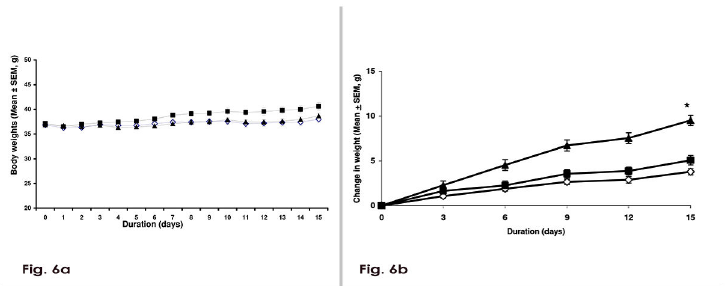
Figure 6. P1736 did not adversely affect body weight in preclinical diabetic models. a , Body weights of male db/db mice treated with vehicle (empty diamonds) or P1736 (150mg/kg, solid square) or metformin (solid triangle) for 15 days. Body weight was measured daily and recorded. b , Change in the weights of db/db mice treated with vehicle(empty diamonds) or P1736 (5 mg/kg twice daily, solid squares) or rosiglitazone (5 mg/kg, solid triangles) for 15 days. Data are expressed as Mean ± SEM for 7 - 10 animals per treatment group. * p< 0.05 compared to vehicle.